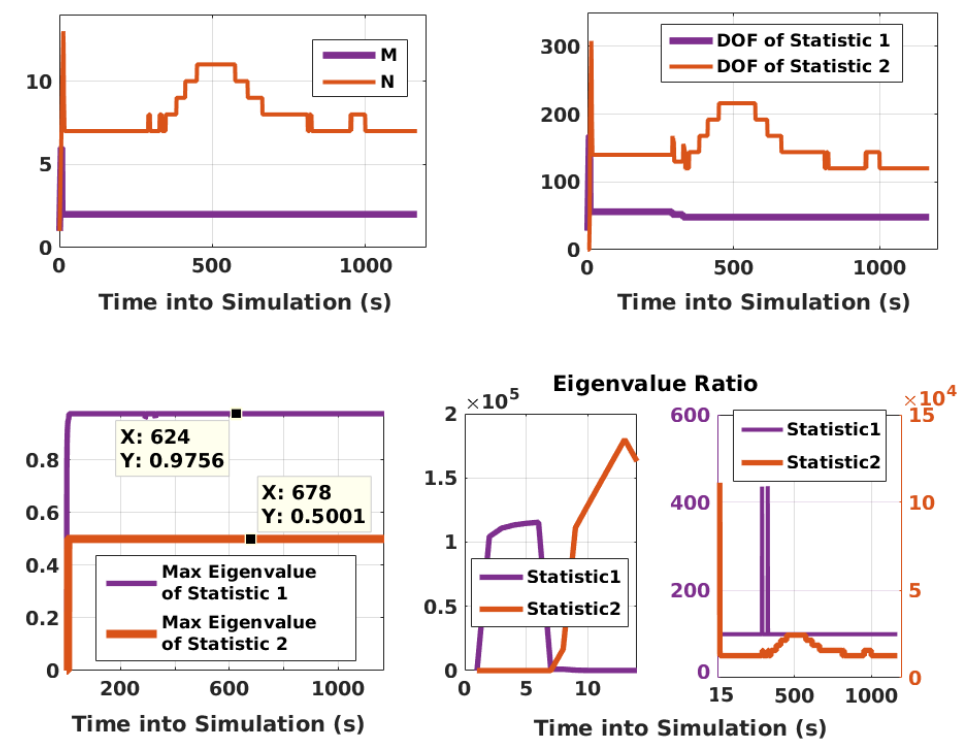
Figure 9. Important parameters of KF